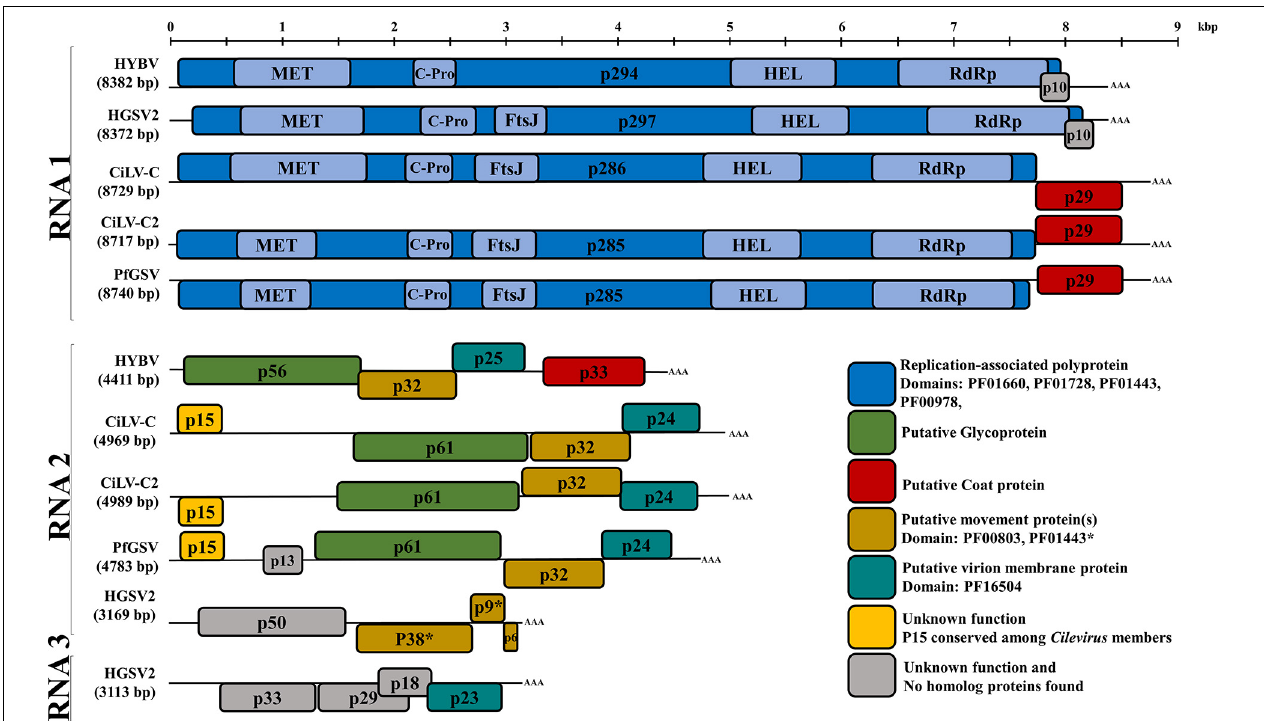
FIGURE 2 | Genome organization comparison between hibiscus yellow blotch virus (HYBV) and Cilevirus and Higrevirus members. Boxes represent open reading frames (ORFs), and similarly colored ORFs encode proteins of similar function as indicated. RNA 1 (8382 bp) contains two ORFs coding for the replication-associated polyprotein (p294) and a protein with unknown function (p10). RNA 2 (4411 bp) contains four ORFs coding for the putative glycoprotein (p56), putative movement protein (p32), putative virion membrane protein (p25) and putative coat protein (p33). Cileviruses represented: citrus leprosis virus C (CiLV-C) and CiLV-C2, and the proposed cilevirus, passion fruit green spot virus (PfGSV). Higreviruses represented: hibiscus green spot virus 2 (HGSV2). MET, methyltransferase; C-Pro, cysteine like protease; FtsJ, methyltransferase; HEL, helicase; RdRp, RNA-dependent RNA polymerase; AAA, poly(A) tail. Scale at top of figure indicates approximate size in kilobase